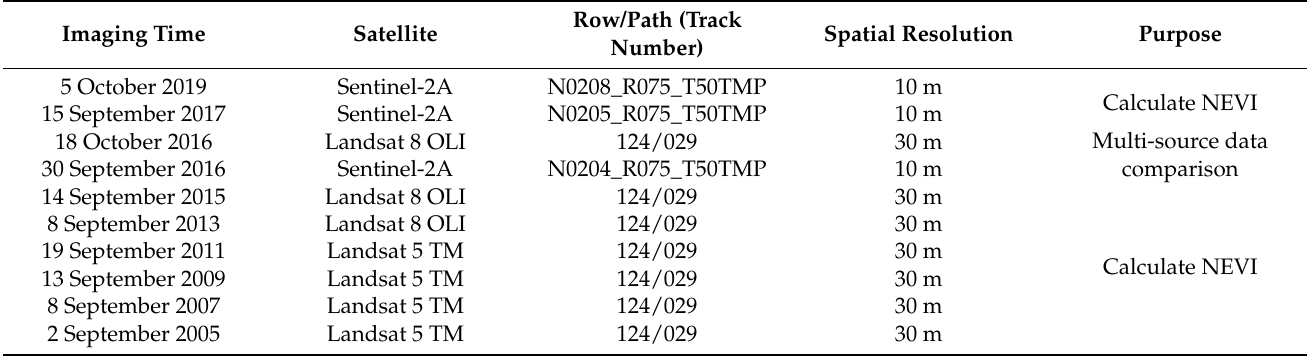
Table 1. Information of remote sensing data.